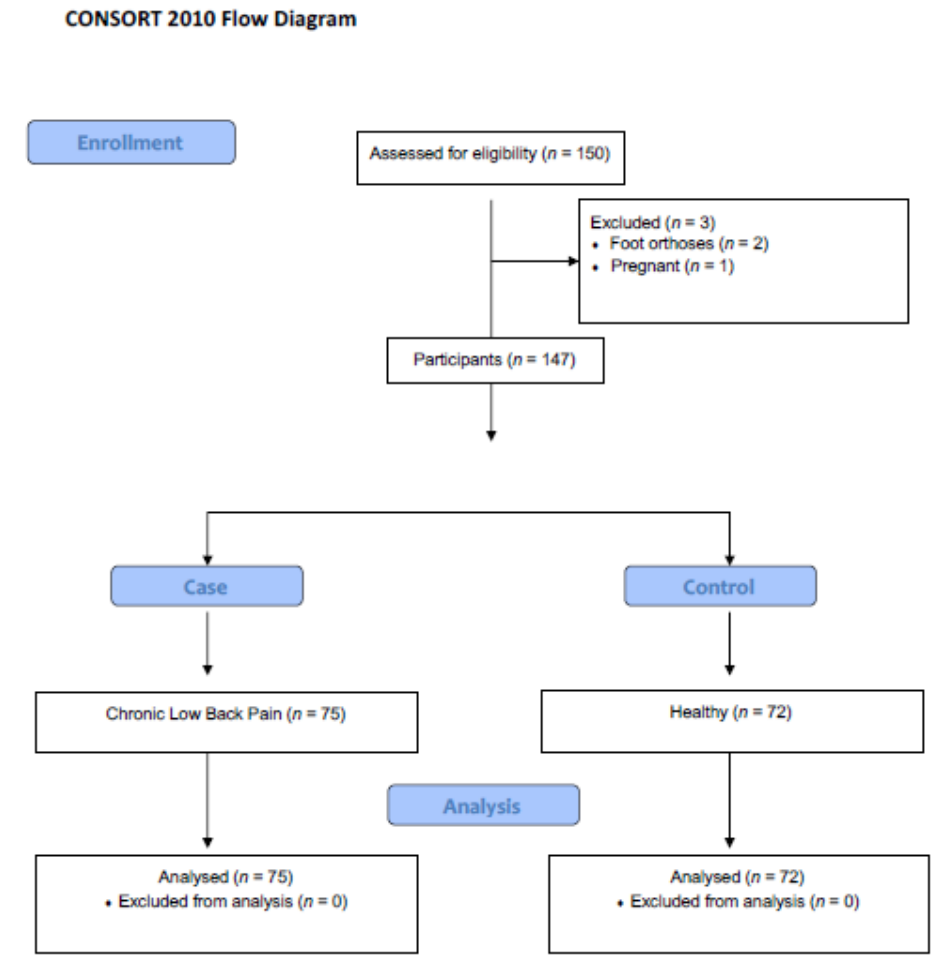
Figure 1. CONSORT flow diagram.